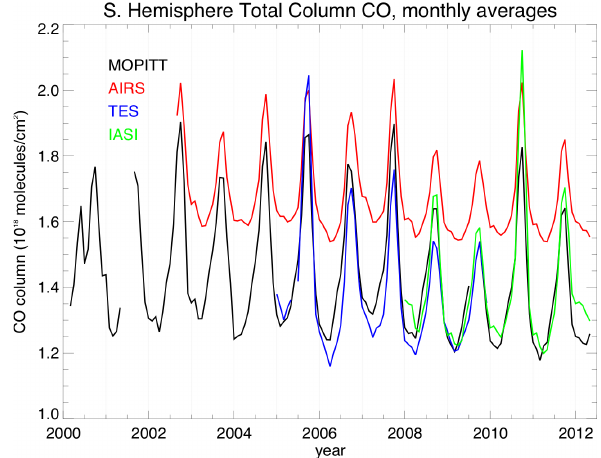
Figure 4. Time series of S. hemisphere (0-­‐60°S) monthly averages. Fig. 4. Time series of S. Hemisphere (0 ◦ –60 ◦ S) monthly